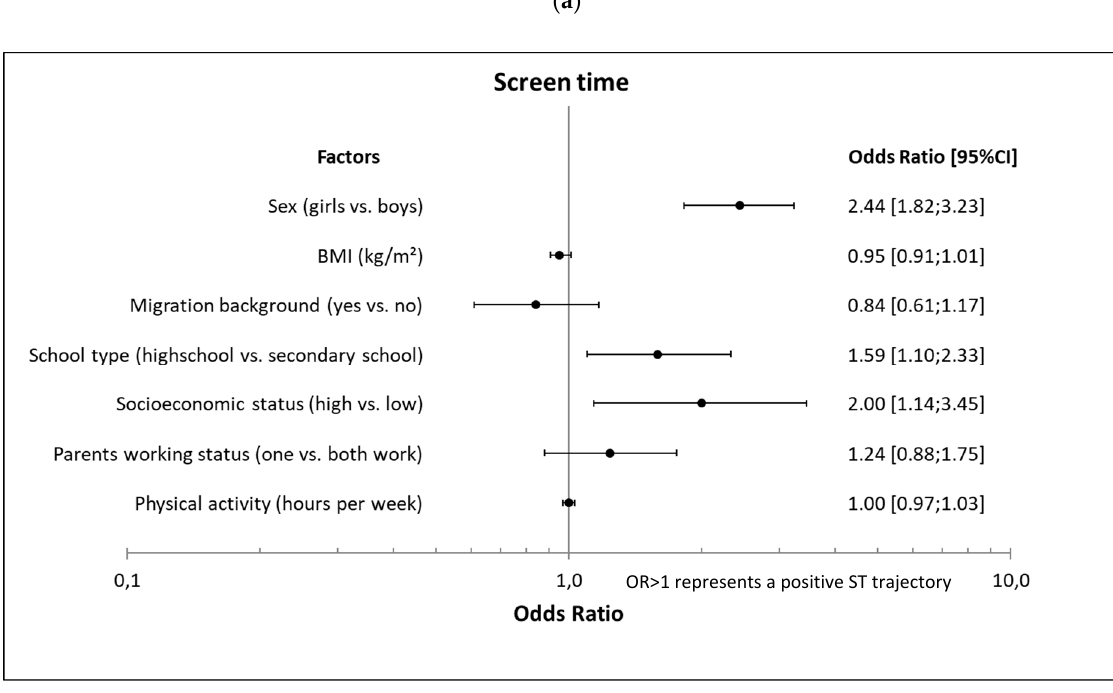
Figure 2. Associations of potential determinants with a positive ( a ) PA (N = 1247) and ( b ) ST (N = 1316) trajectory among 7th to 9th grade students.